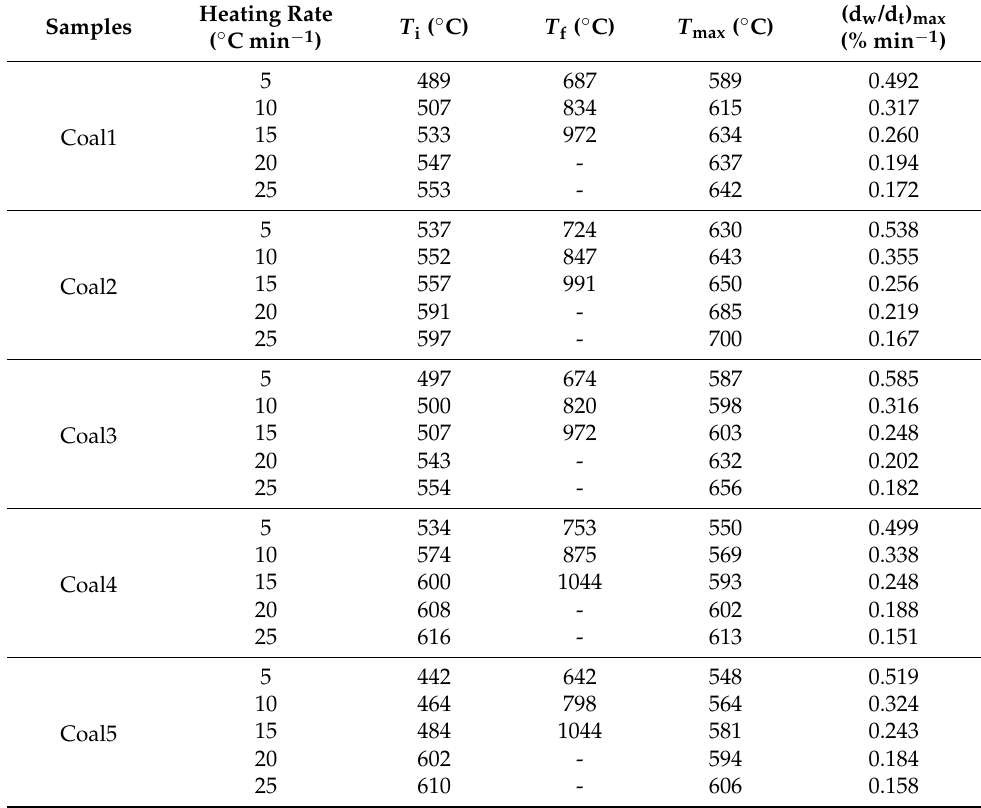
Table 2. Combustion parameters of bituminous coal